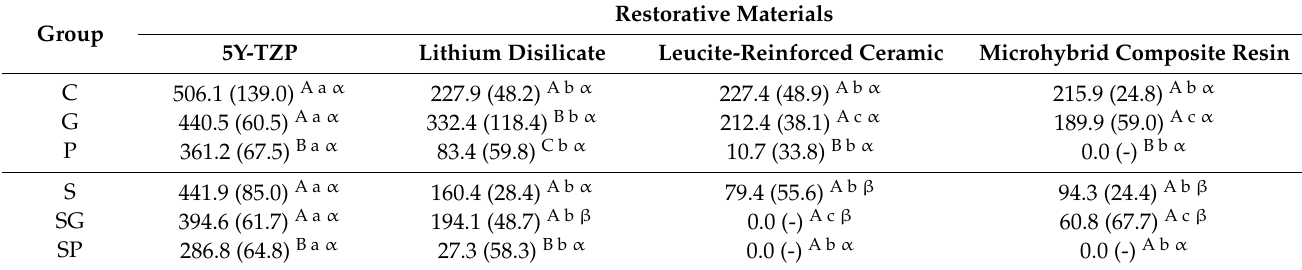
Table 2. The vertical height loss (VHL) of hemispheres (µm) opposing stabilized zirconia with 5 mol% of yttrium oxide (5Y-TZP), lithium disilicate, leucite-reinforced ceramic, and microhybrid composite resin for all groups.